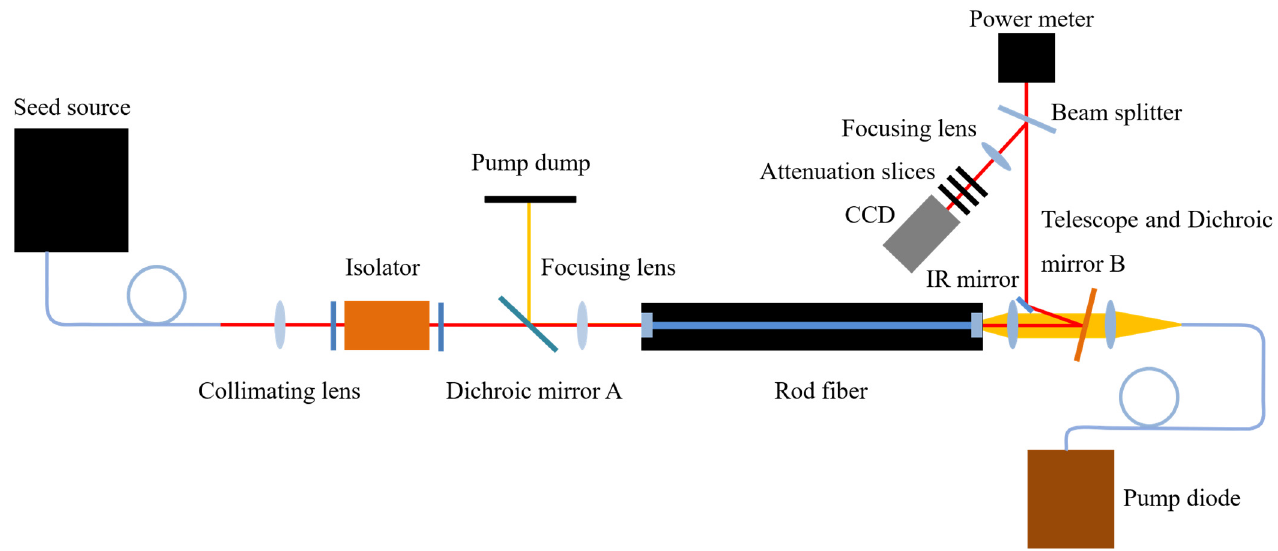
Figure 10. The scheme of the rod fiber amplification system.